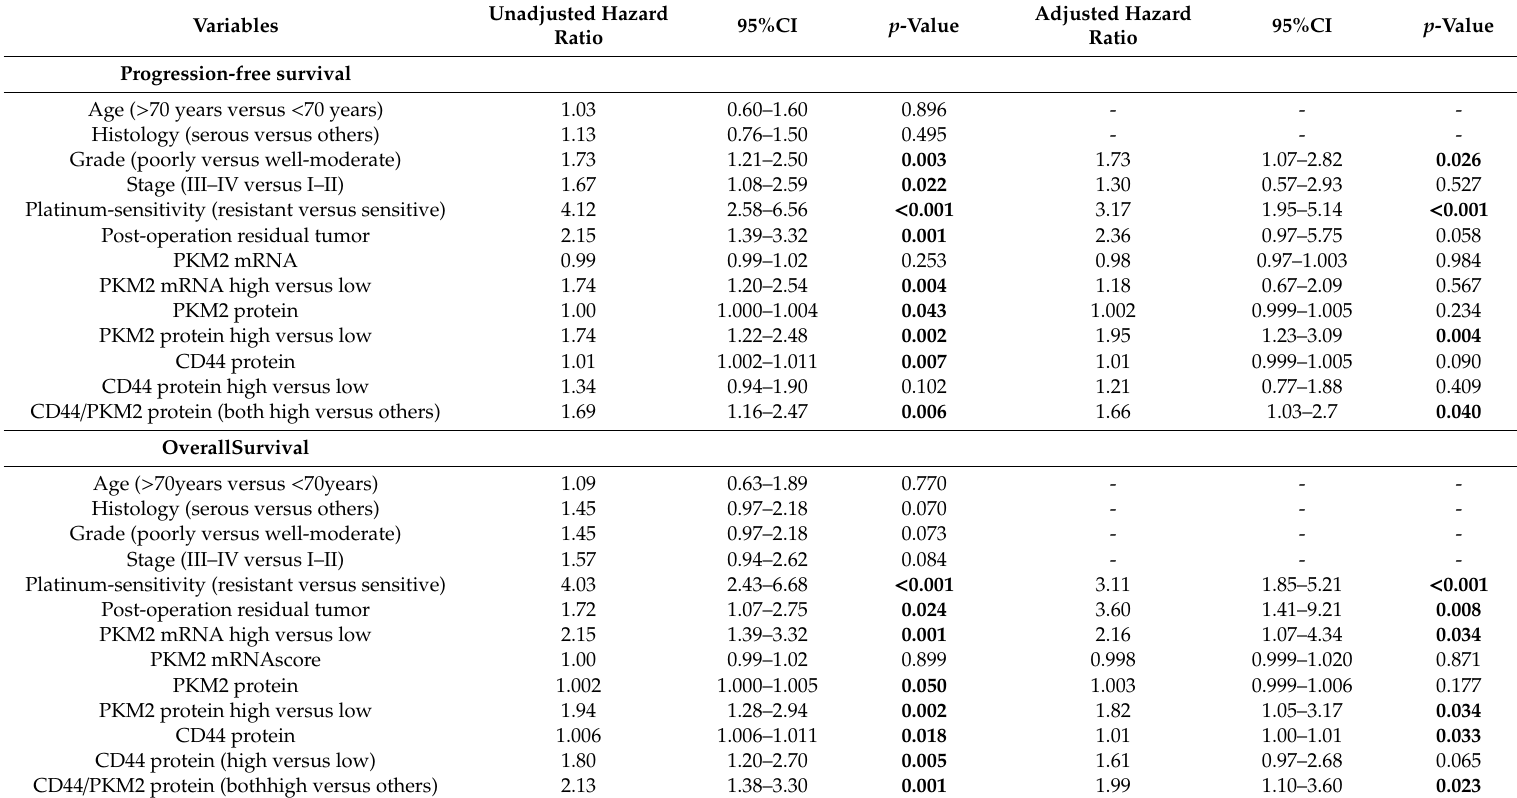
Table 3. Univariate and multivariate analysis for PFS and OS of EOC patients treated with platinum-based